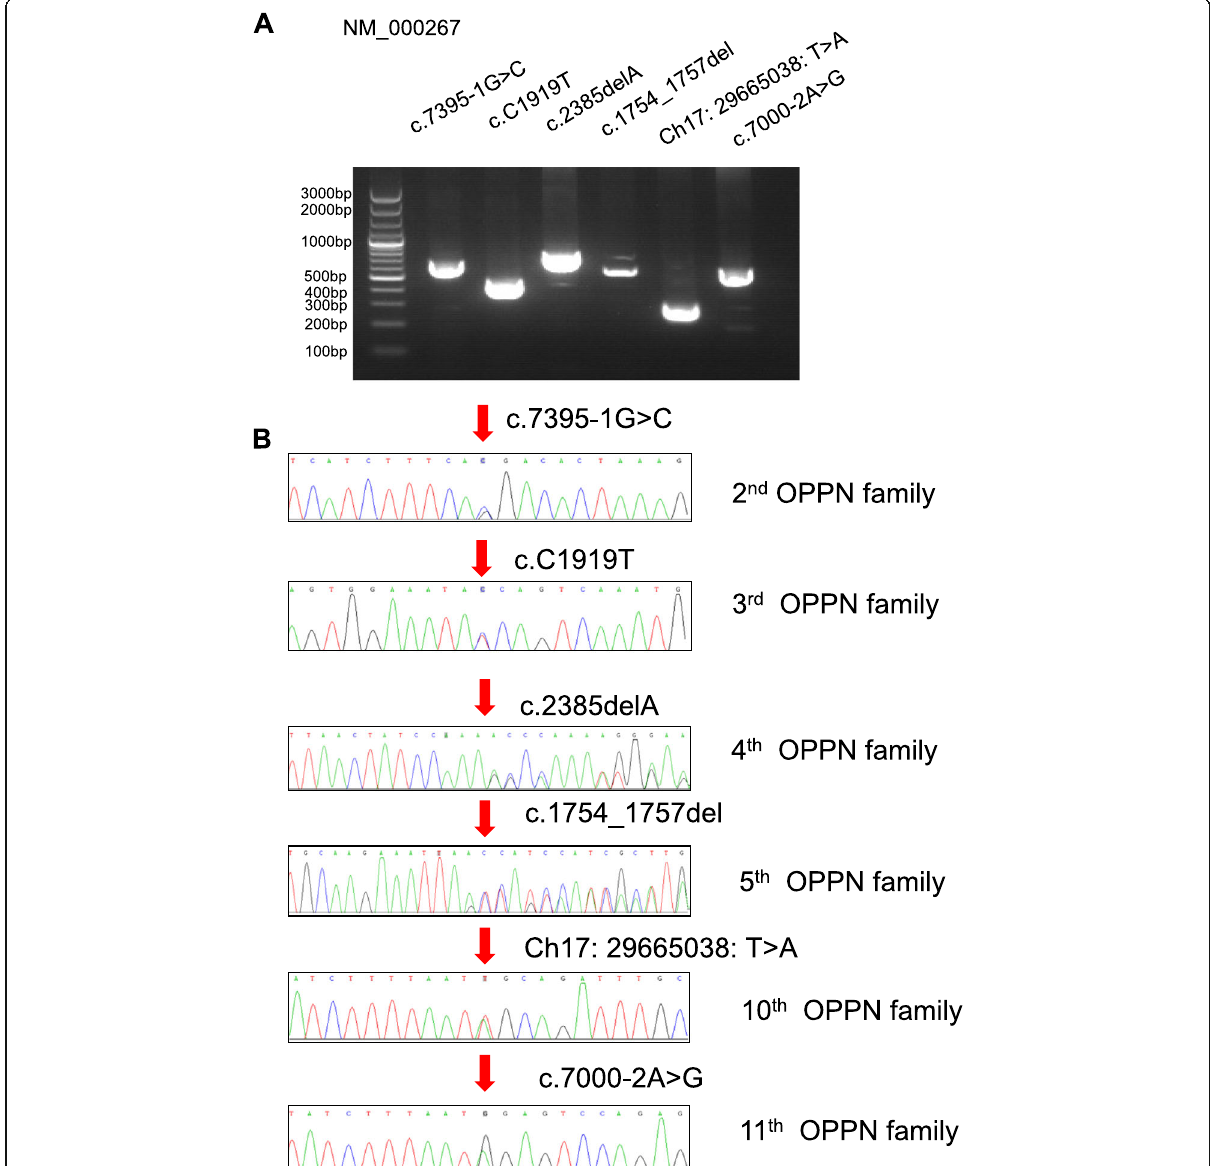
Fig. 3 PCR gel images and Sanger chromatogram indicating novel NF1 mutations. a PCR gel images of each mutated NF1 genomic fragment. b Sanger chromatogram of each novel NF1